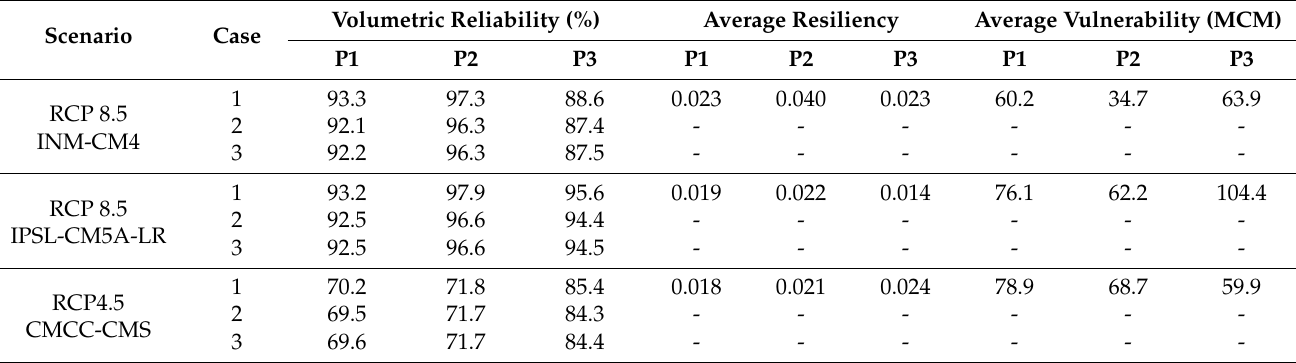
Table 7. Results of the three model performance evaluation indices for Case 1, 2, and 3 in the Hapcheon reservoir.